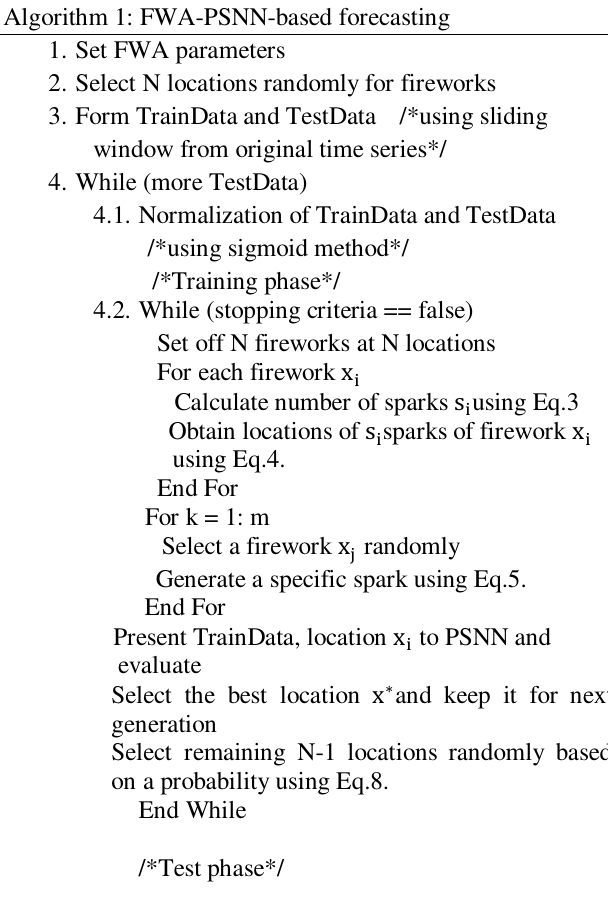
Algorithm 1: FWA-PSNN-based forecasting 1. Set FWA